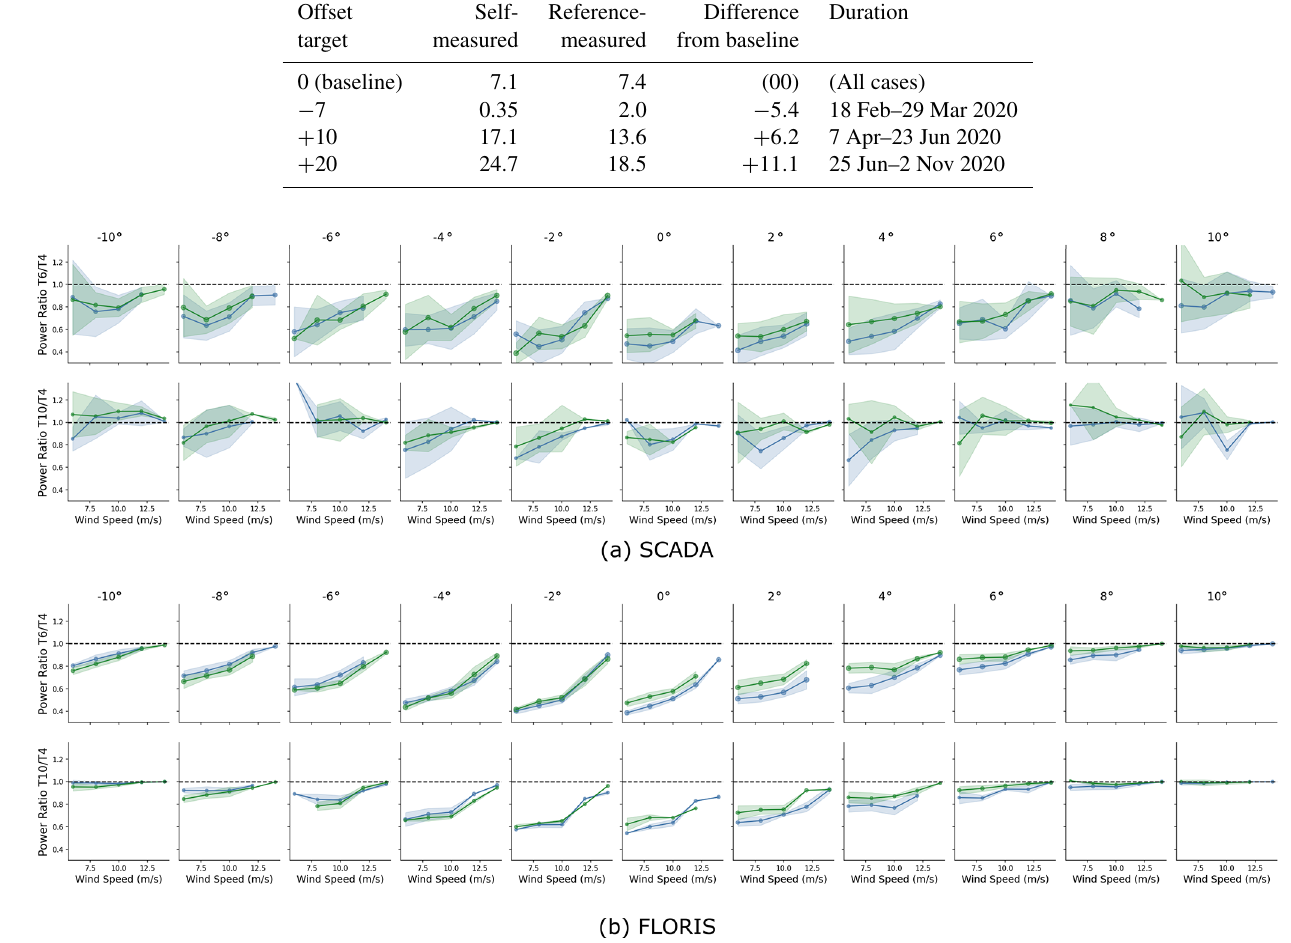
Figure 6. Comparison of power ratios for T6 and T10, with respect to reference T4, for both SCADA data and FLORIS resimulations. The size of the circles indicates the number of points in a given bin, and the shaded area indicates a 95% confidence interval of the mean. Note that wind direction has been shifted in these plots so 0 ◦ is the angle when the downstream wind turbine is fully waked. To save space, the legend is not shown, but as in Fig. 5, green represents the controlled case and blue is the baseline.